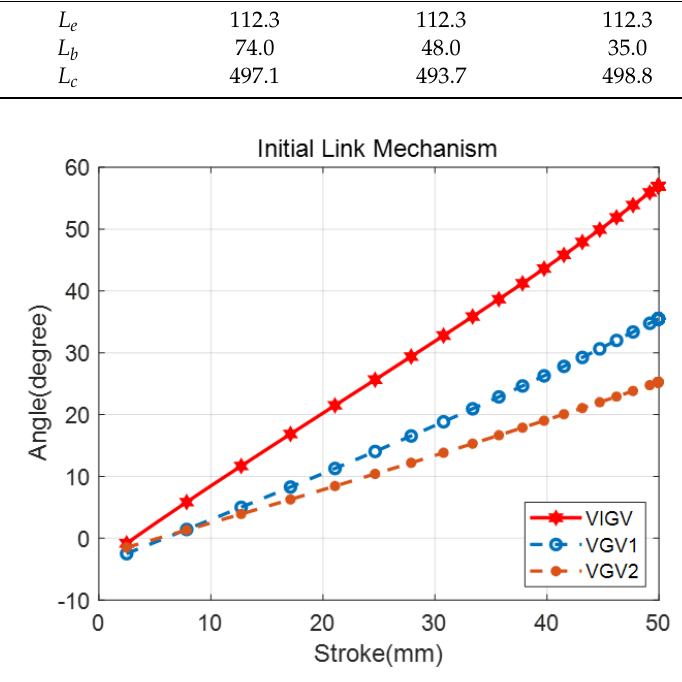
Figure 10. Link mechanism results based on the initial geometry.